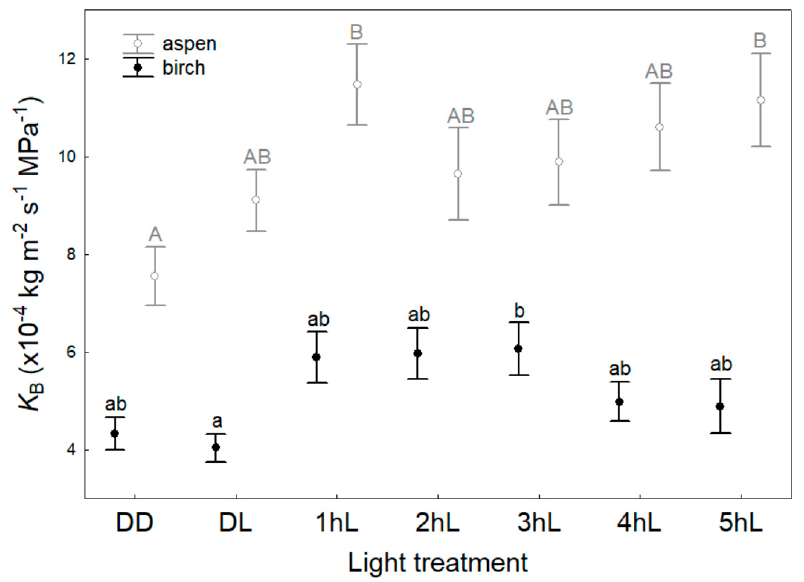
Figure 2. Mean values ( ± SE) of branch hydraulic conductance ( K B ) depending on species and light treatment. DD—initial dark conditions; DL—initial light conditions (exposure to light for less than 1 h); 1 hL–5 hL—light conditions (exposure to PPFD 900–1000 µ mol m − 2 s − 1 for 1–5 h).